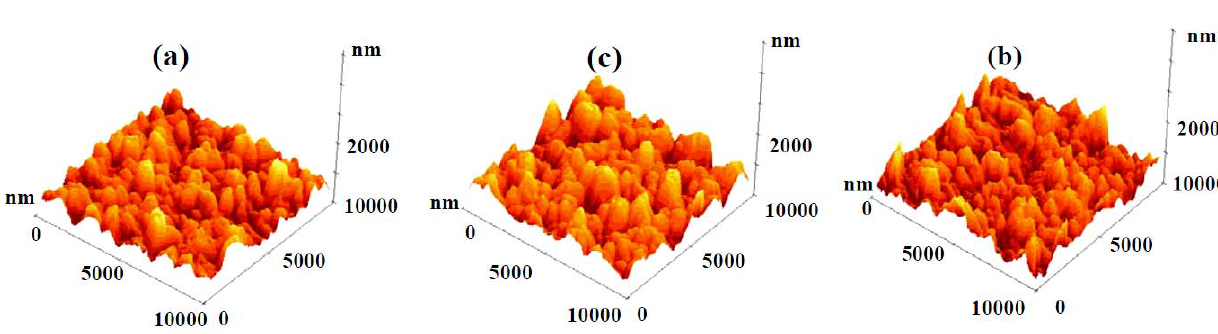
Figure 7. AFM images of template assisted Y layer: ( a ) 30 nm, ( b ) 60 nm, and ( c ) 80